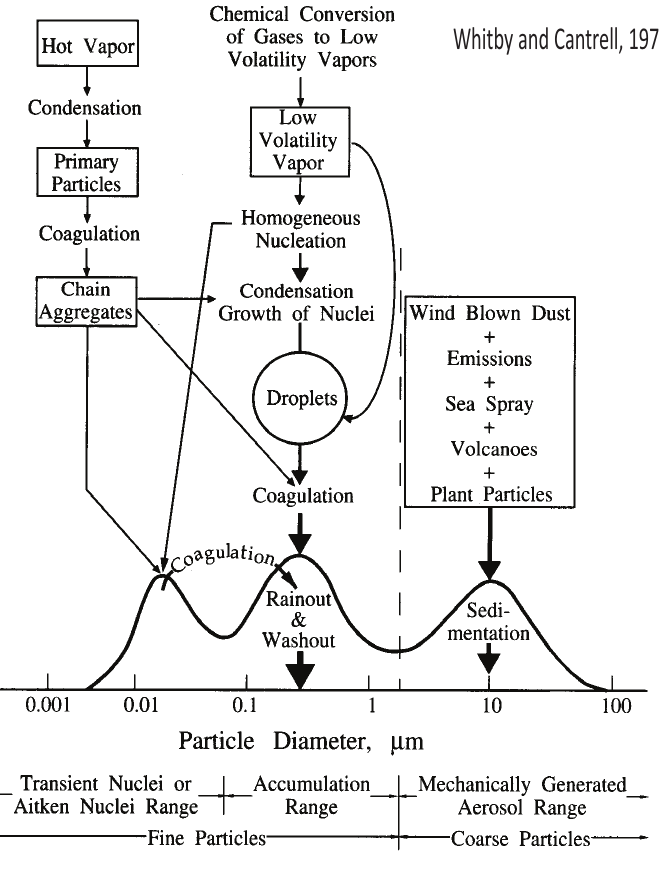
Figure 2. Idealized schematic of atmospheric aerosol cycles including sources, sinks, particle modes and particle creation as a function of particle diameter in µ m. From Whitby and Cantrell [44].